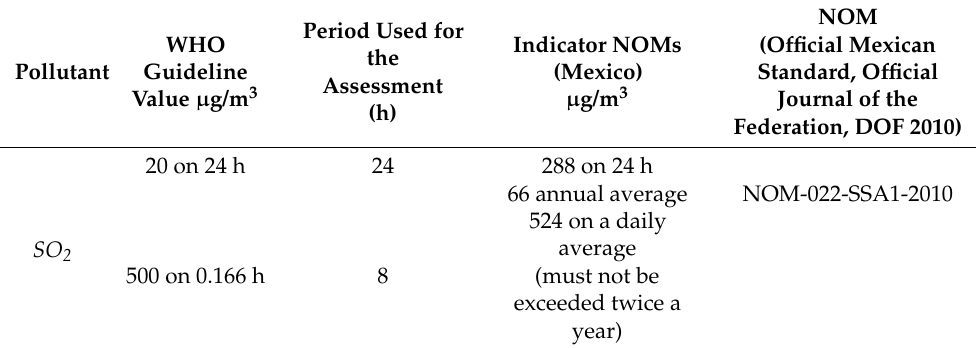
Table 1. Normative values for SO 2 standard WHO’s Mexico